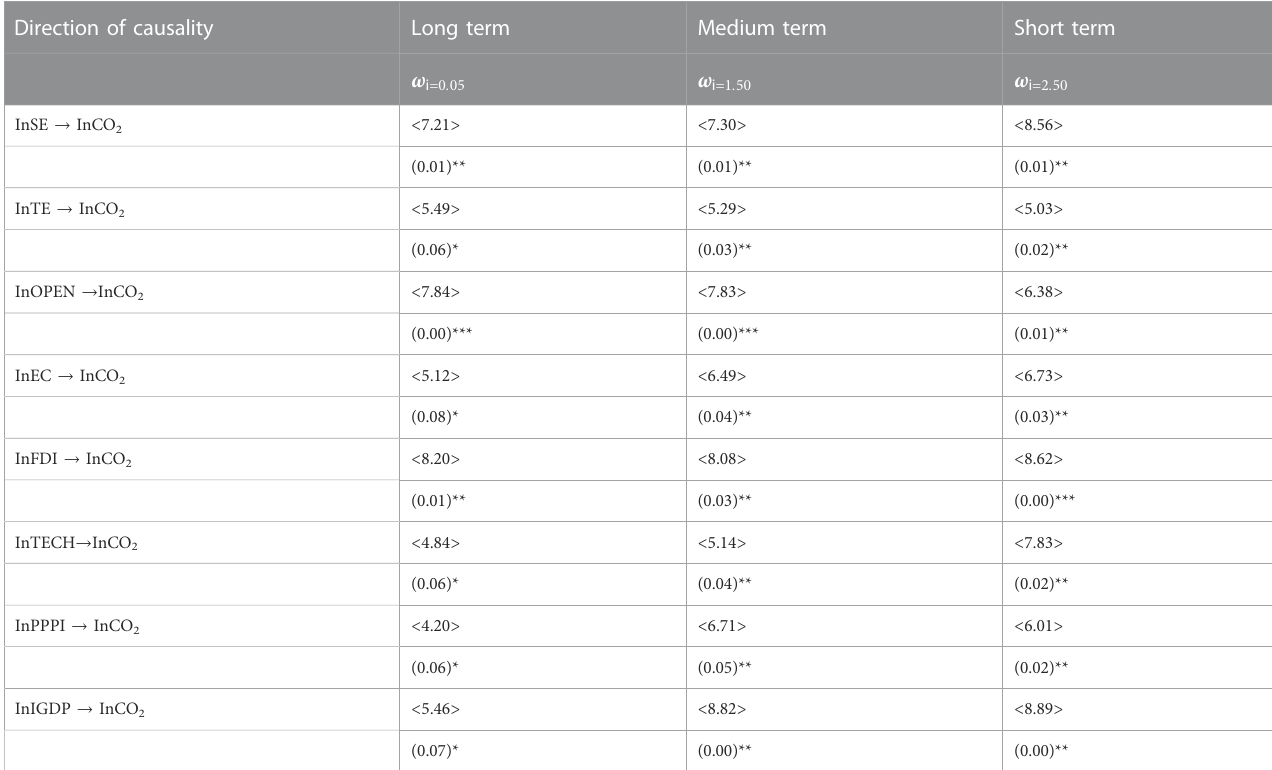
TABLE 9 Frequency-domain causality test.